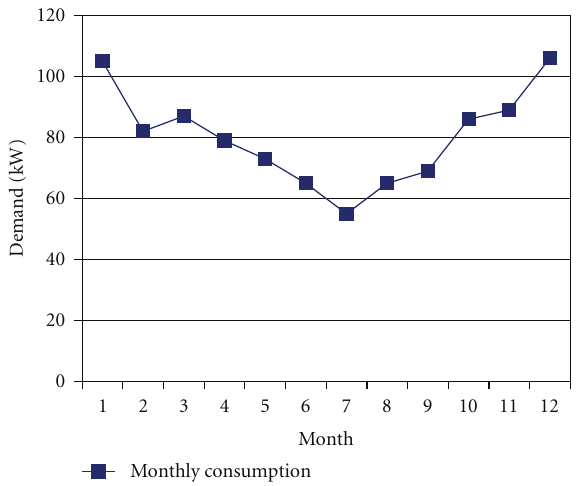
Figure 8: The collector e ffi ciency (BH city data).